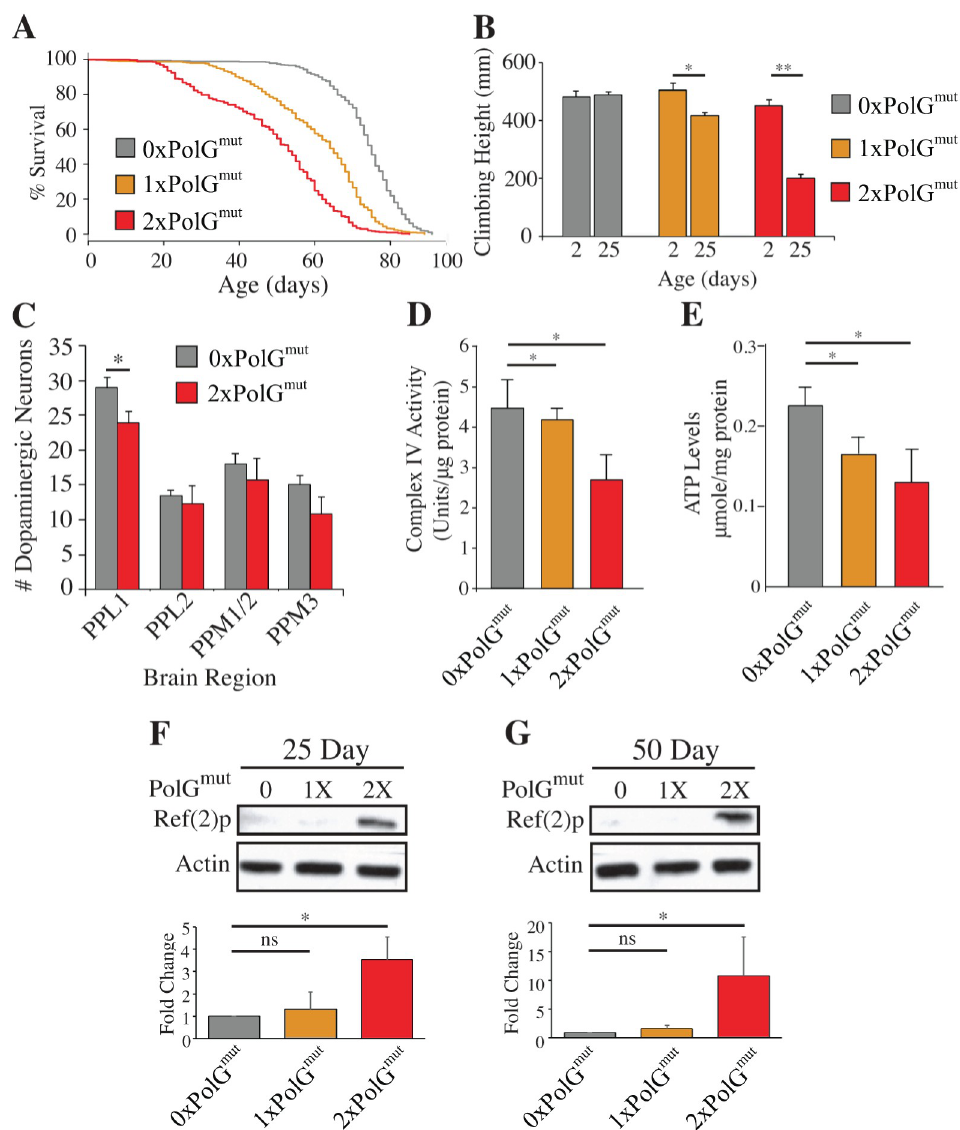
Fig 4. mtDNA mutator flies exhibit shortened lifespan, a locomotion defect, neuron loss, and mitochondrial dysfunction. (A) The lifespan of male flies of the indicated genotypes are shown (n � 364 flies per genotype). � p < .001 determined by log-rank test. (B) The mean distance climbed by male flies of the given ages and genotypes in 3 seconds (n � 54 flies per genotype per time point). (C) Quantification of dopaminergic neurons within the indicated clusters of in 50-day-old control and 2xPolG mut flies. PPL1, protocerebral posterior lateral; PPM, protocerebral posterior medial (D) Complex IV activity is inversely correlated with PolG mut dosage in 14-day-old flies (n = 4 male flies per genotype). (E) ATP abundance is similarly decreased in 14-day-old 1xPolg mut and 2xPolg mut flies. (F) and (G) Ref(2)P/p62 abundance is selectively increased in 25- and 50-day-old 2xPolg mut flies, respectively. Error bars in panels B and C represent standard deviation, error bars in panels D-G represent standard error. � p < 0.05; �� p < 0.01 by Student’s